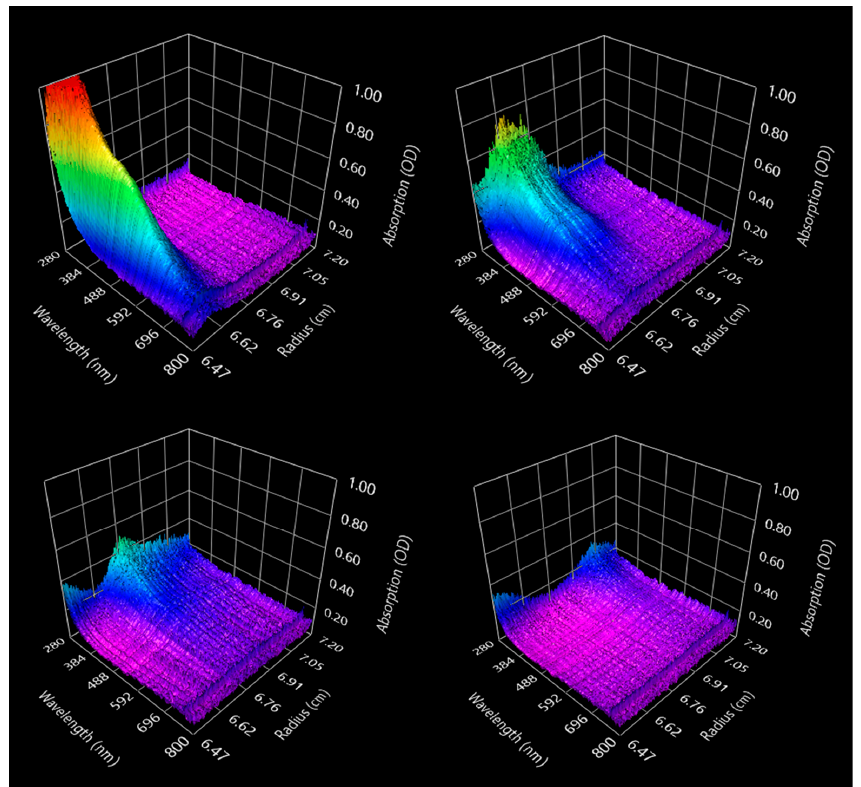
Figure 1 . Analytical ultracentrifugation (AUC) raw data of a band forming experiment for the in situ nucleation of gold clusters obtained from the multiwavelength AUC at different times of the experiment. Shown are scans after: 3.8 min ( top left ), 7.7 min ( top right ), 13.8 min ( bottom left ), 24.5 min ( bottom right ). The absorbance of the species over the whole cell and their sedimentation from the top of the cell (5.8 cm radius) to the bottom (7.2 cm radius) can be followed. The particles present in the boundary are visible in the first scan and then the sedimentation toward the bottom and the broadening of the boundary due to diffusion can be observed.